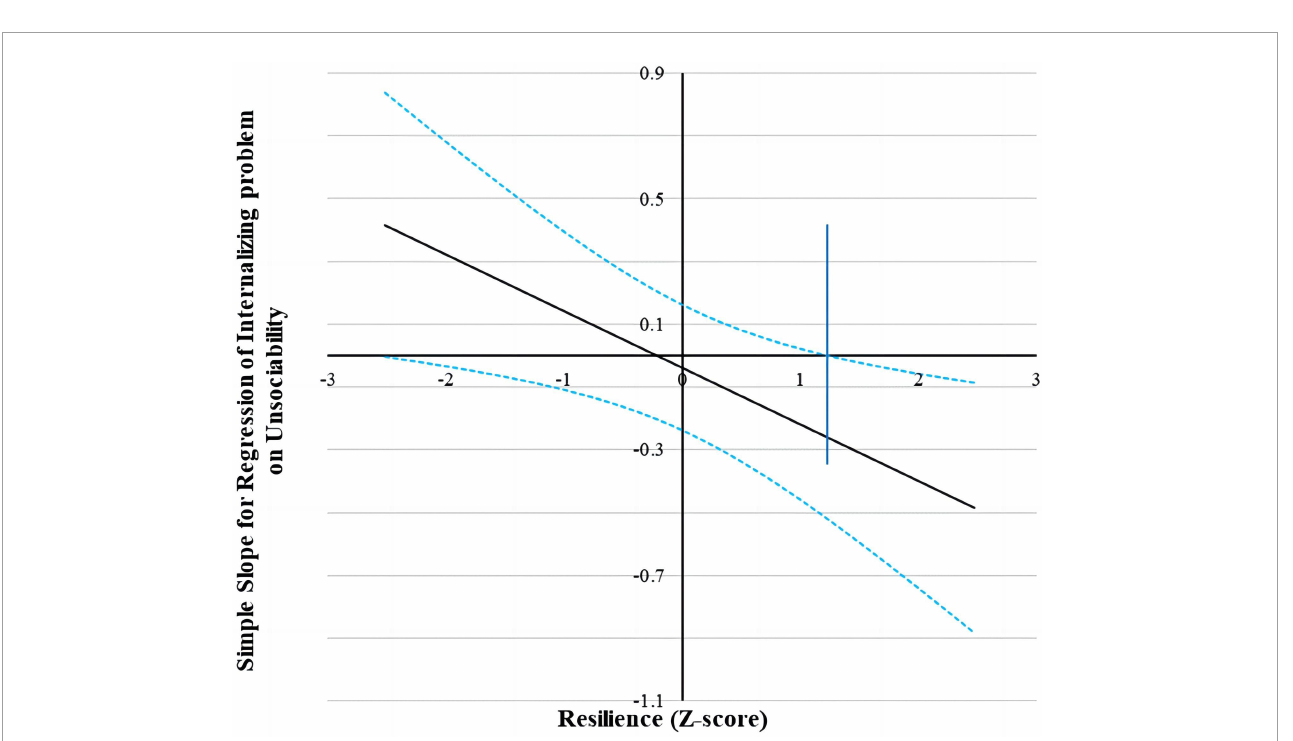
FIGURE3 Johnson–Neyman regions of significance and confidence bands for mother-rated unsociability along resilience in relation to internalizing problems. Solid diagonal line represents the regression coefficient for unsociability along resilience. Dashed diagonal blue lines are confidence bands–upper and lower bounds of 95% confidence interval for unsociability regression coefficient along resilience. The vertical blue line indicates the point along resilience at which the unsociability regression coefficient transitions from non-significance (left of dashed vertical line) to statistical significance (right of dashed vertical line). The value of the dashed vertical line is